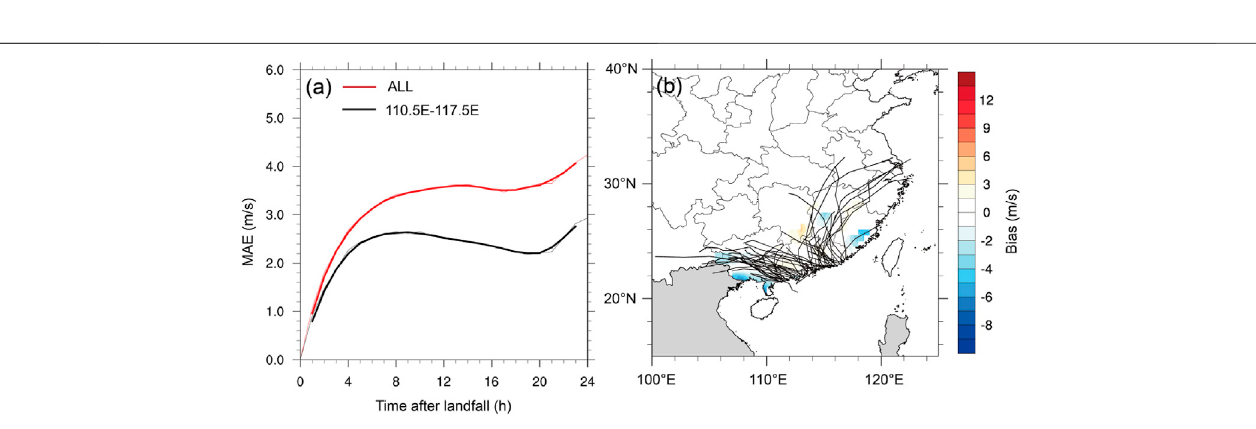
FIGURE9|(A) DistributionofMAE(ms − 1)ofM3forallsamplesoflandfallingTCs(redline)andforTCsmakinglandfallalongtheSouthChinacoast(110.5 ° – 117.5 ° , black line). (B) The spatial distribution of biases (m s − 1 ) in M3 for TCs making landfall along the South China coast. The black lines in (B) represent the tracks of landfalling